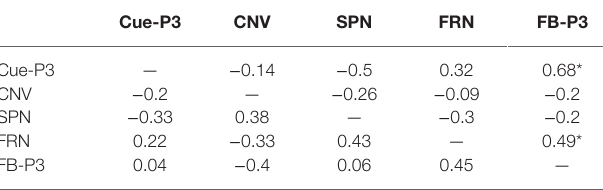
TABLE 2 | The correlation among different ERP